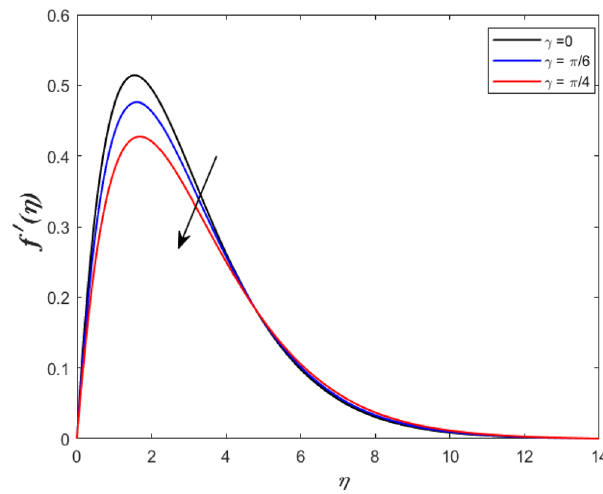
Figure 11. Inspiration of γ on velocity